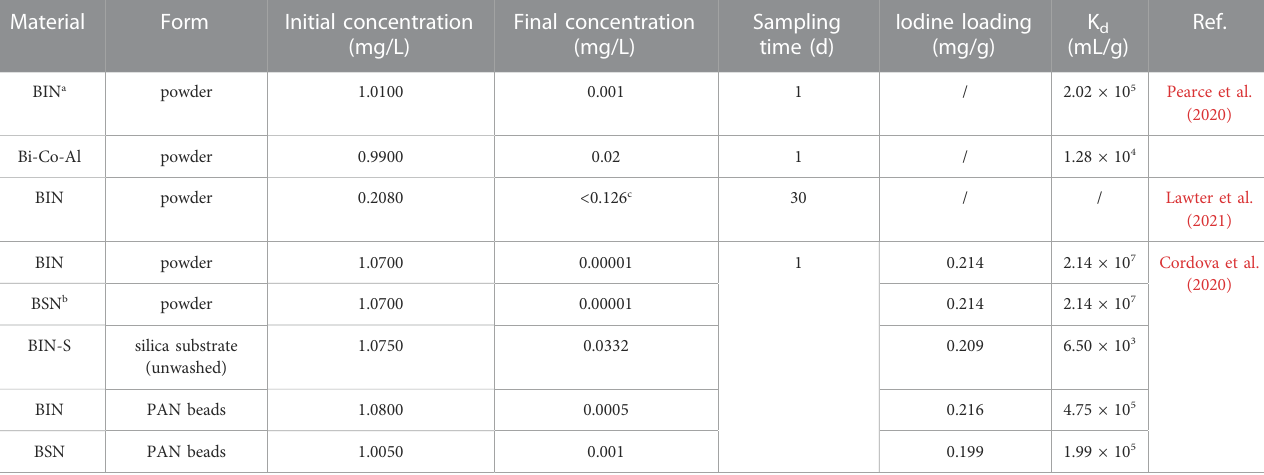
TABLE 2 Batch experiments of some Bi-based materials in synthetic groundwater. Material